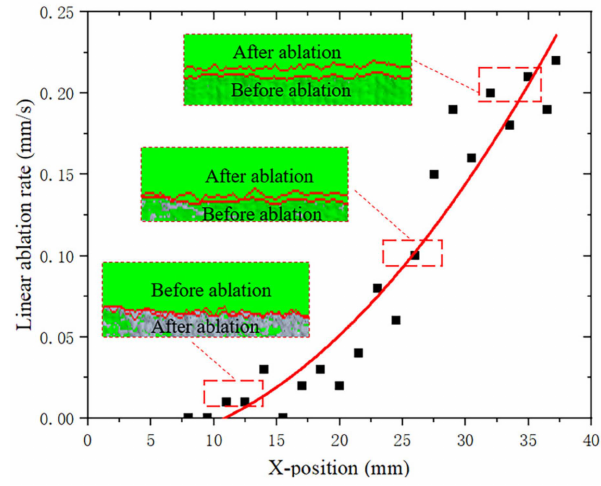
Figure 6. Ablation rate of the combustion chamber.